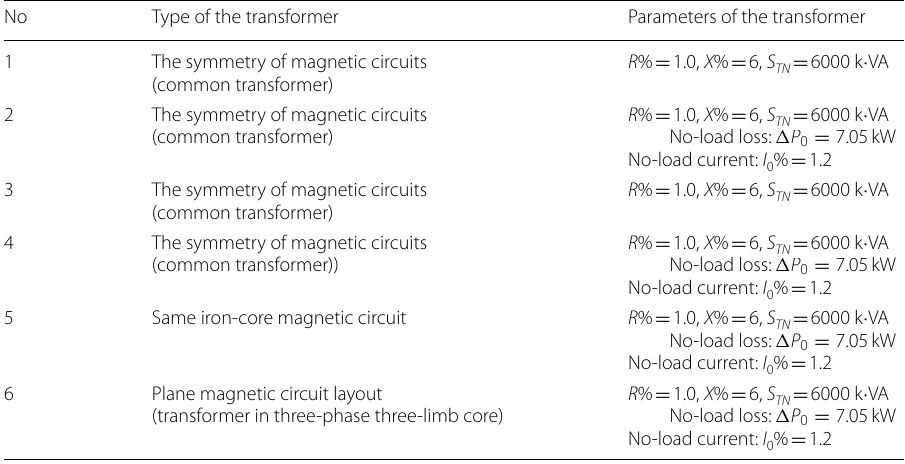
Table 2 Magnetic circuit types and the parameters of the transformers No Type of the transformer Parameters of the transformer 1 The symmetry of magnetic circuits (common transformer)